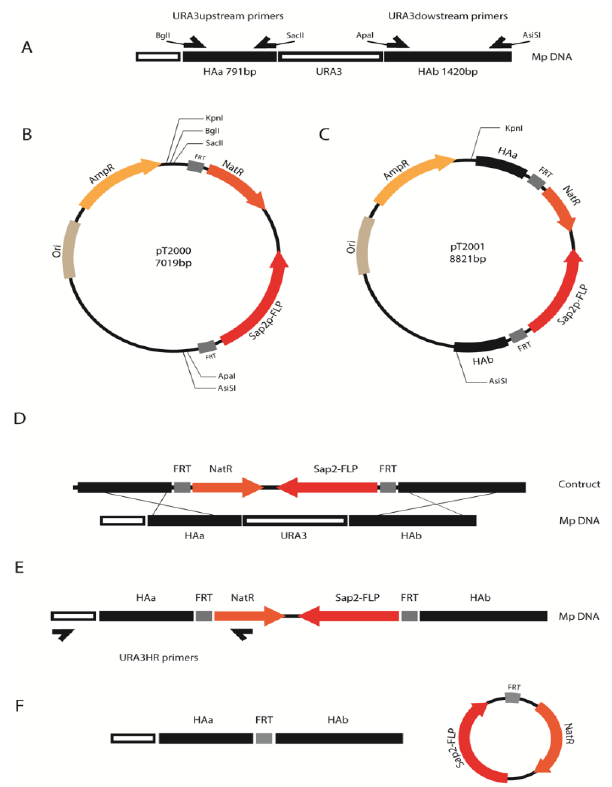
Figure 1. Diagram of the cloning process, homologous recombination and flippase